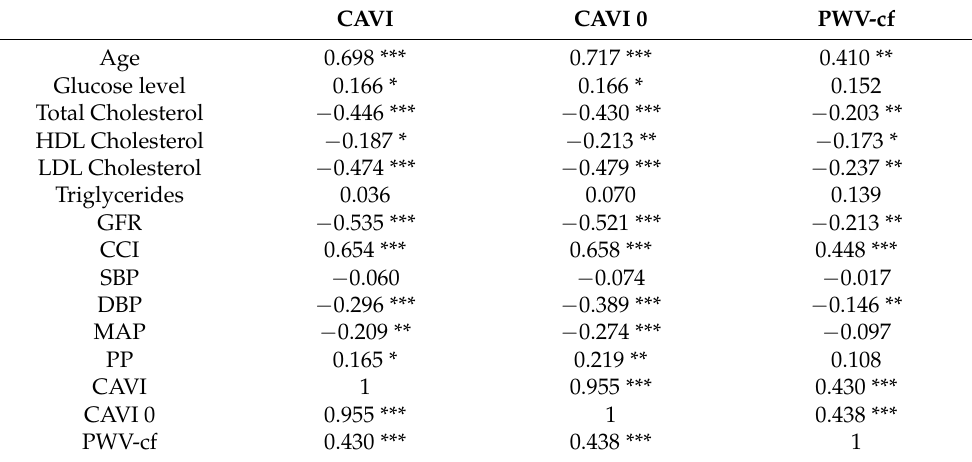
Table 2. Univariate Correlations between CAVI, CAVI0, PWV-cf and the main clinical